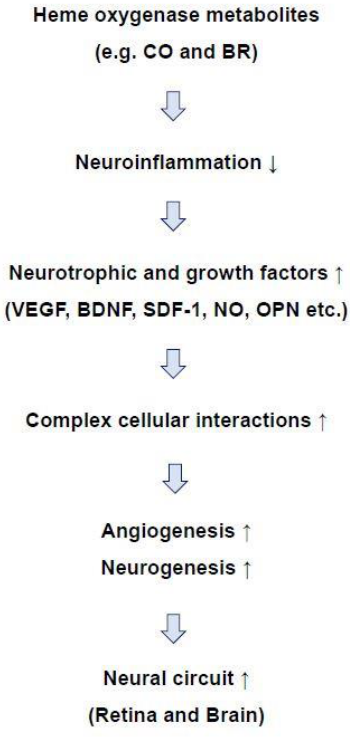
Figure 4. Possible role of heme oxygenase metabolites in a powerful self-repair mechanism. Carbon monoxide and bilirubin may reduce neuroinflammation and increase the secretion of neurotrophic and growth factors. Released factors can bind to their receptors in neighboring cells, such as endothelial cells and neural stem cells, enhancing cellular interactions. Generation of new vessels and differentiation of NSCs into mature neurons may repair neural circuits in the brain and retina.